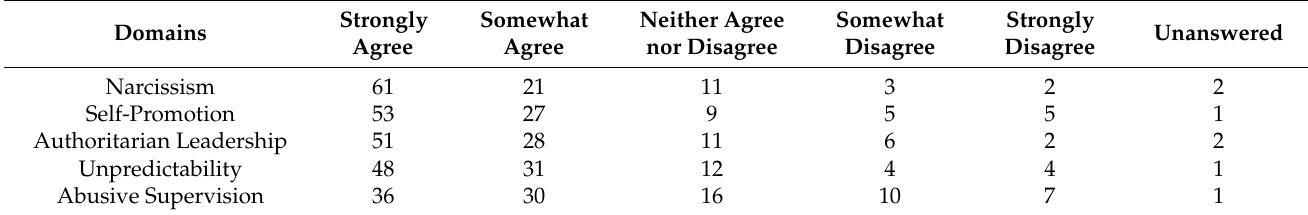
Table 7 illustrates TLS © Domain ranking sorted by “strongly agree” in descending order. Table 7. TLS © domains ranked in order of highest average percentage of participants answering, “strongly agree” to a toxic